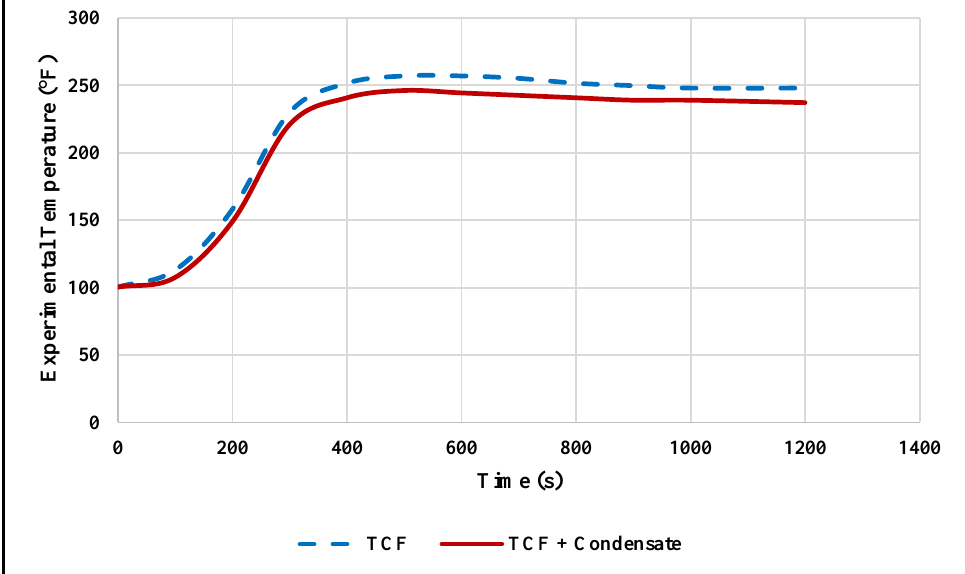
Figure 6. Pressure profiles for a pure thermochemical fluid (TCF) and TCF-condensate system.